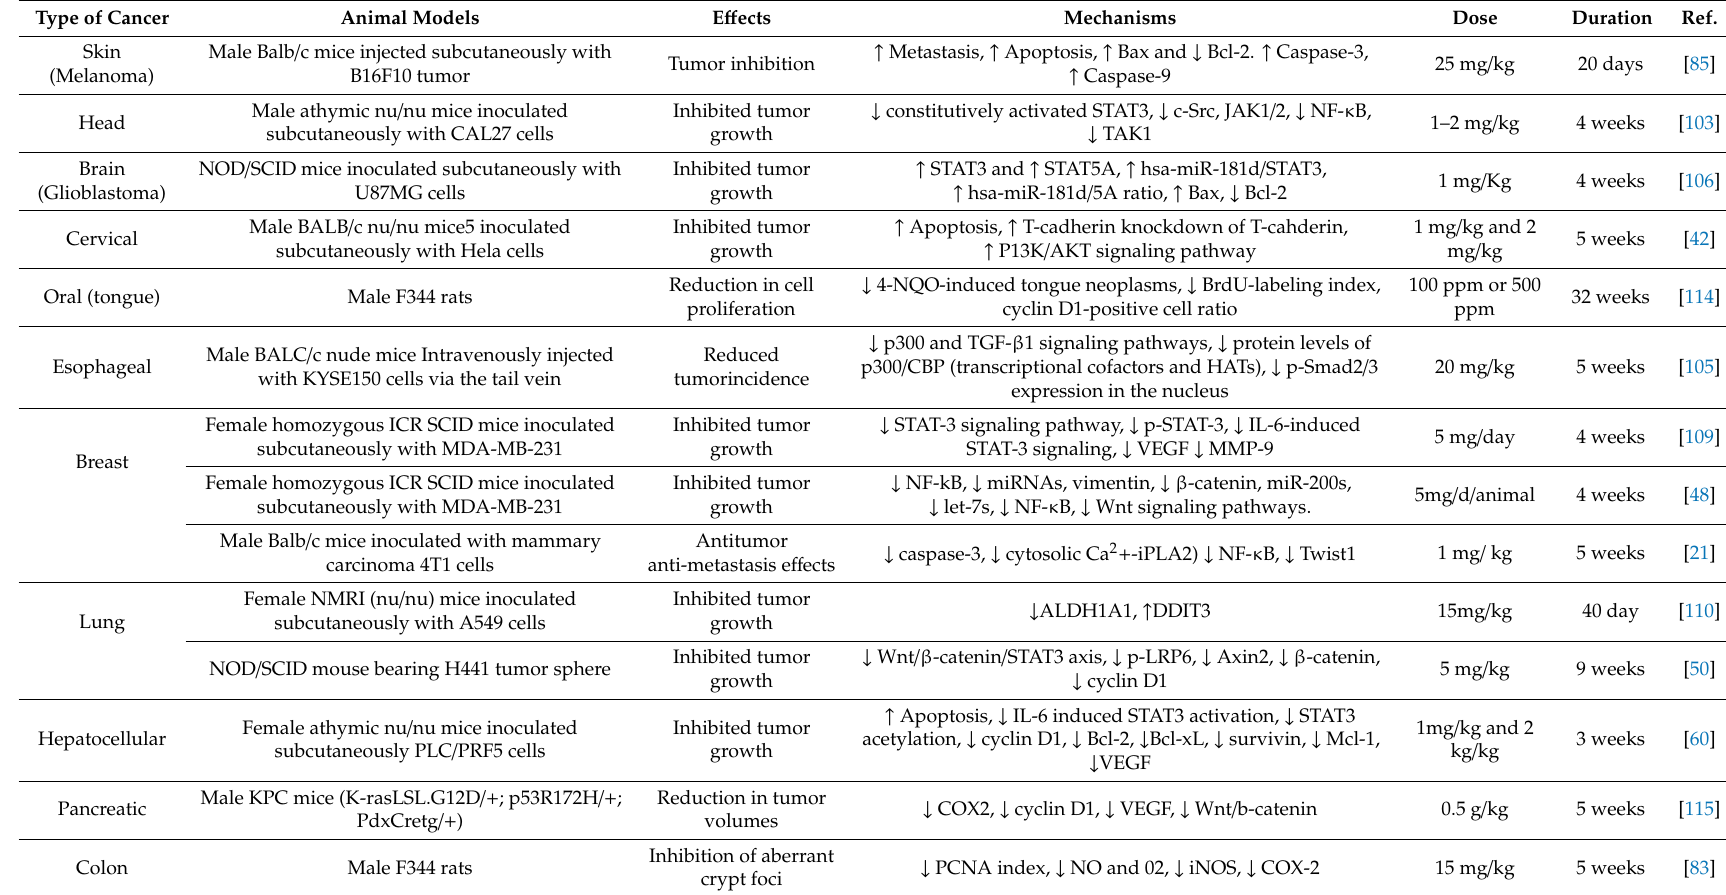
Table 2. Anticancer e ff ects of garcinol based on in vivo